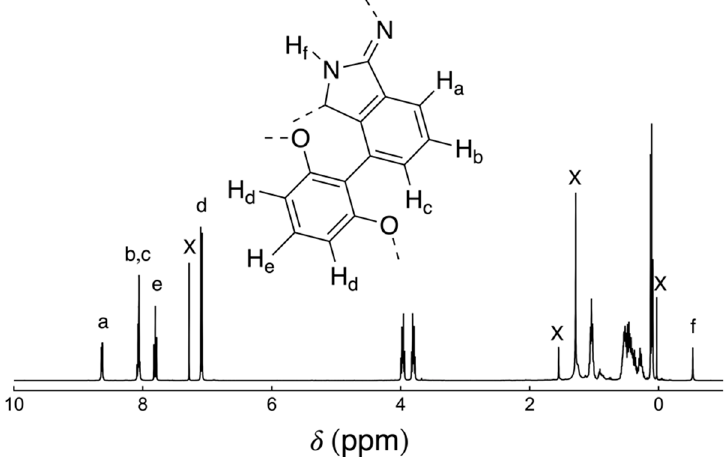
Figure 2. 1 H-NMR spectrum of 1 in CDCl 3 . The signals for residue solvents and the internal standard TMS are denoted as X.